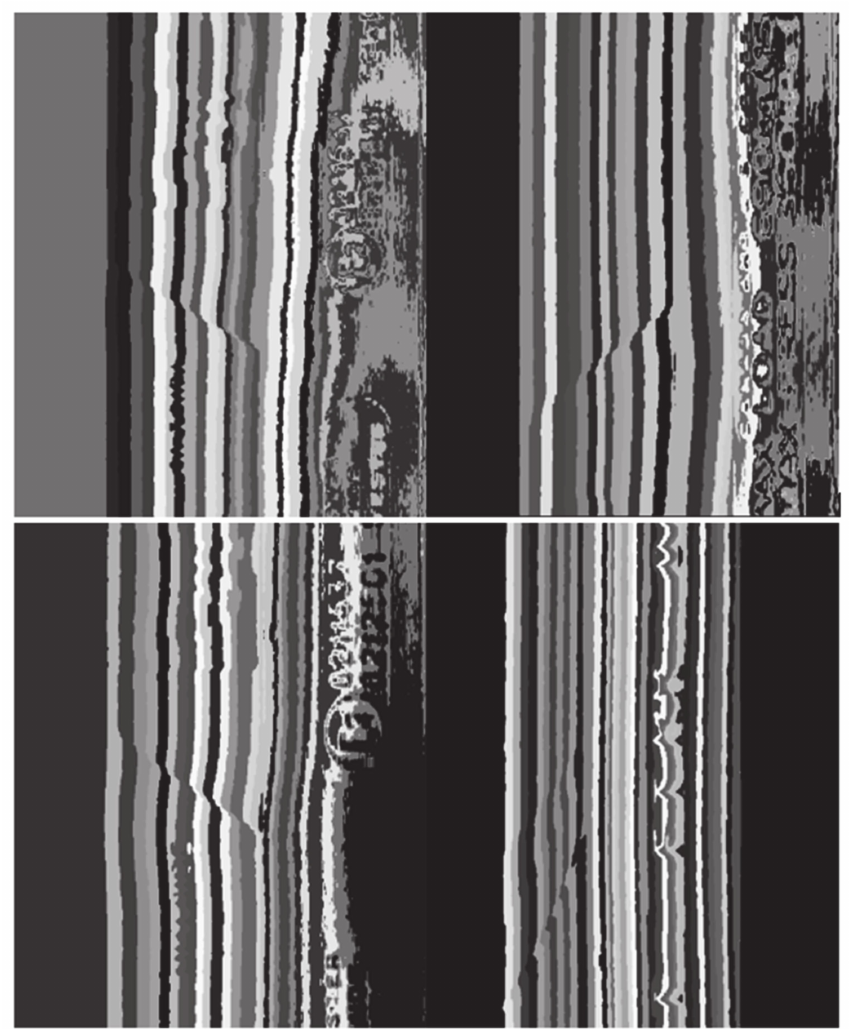
Figure 10. K-Means image processing of the images in the dataset with K =